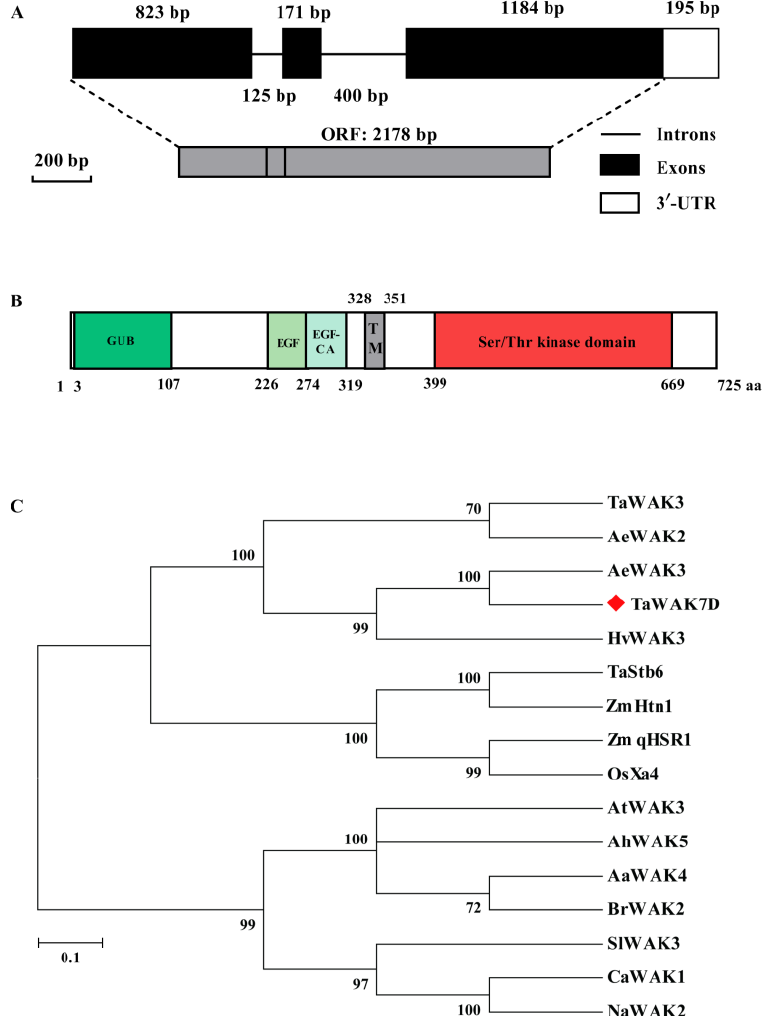
Figure 2. Sequence and phylogenetic analyses of TaWAK7D. ( A ) Gene structure of TaWAK7D . The white box indicates UTR, black boxes represent exons and black lines indicate introns. ( B ) Schematic diagram of the TaWAK7D protein. The colored regions indicate different domains. ( C ) A phylogenetic tree of TaWAK7D and 15 other WAK members from monocots and dicots. The bootstrapped phylogenetic tree was constructed using the neighbor-joining method (MEGA 6.0). The red blot indicates the position of TaWAK7D.